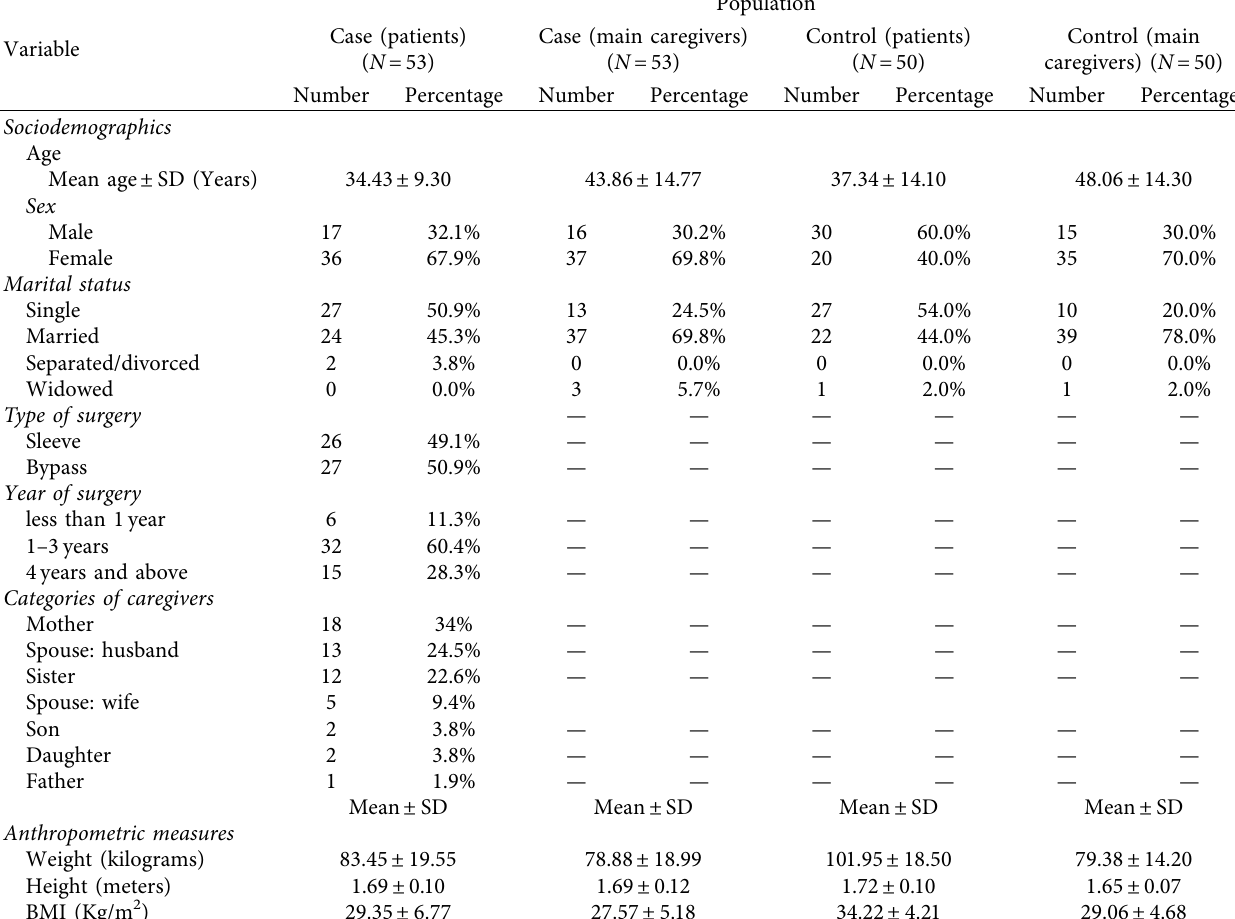
Table 1: Sample characteristics—sociodemographic and anthropometric